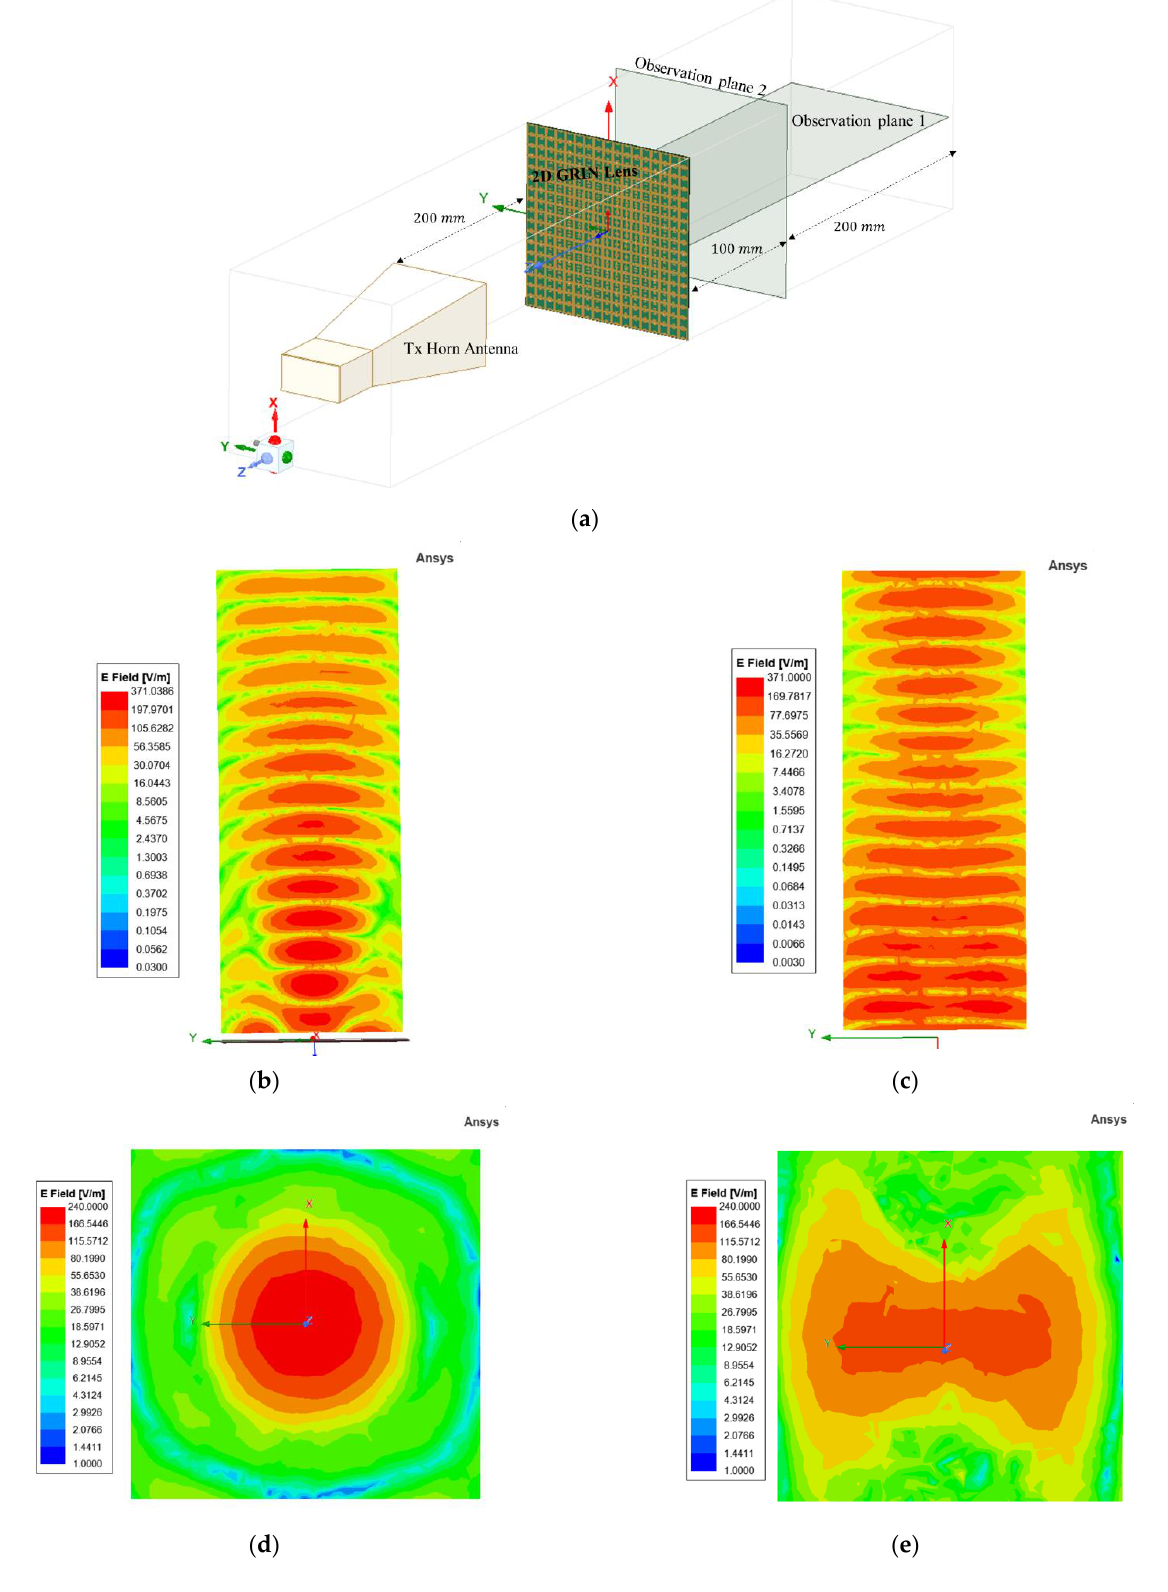
Figure 8. ( a ) Ansys HFSS setup for proposed 2D GRIN Metasurface Lens. ( b ) Azimuthal plane electric field distribution with lens and ( c ) without lens. ( d ) Vertical plane electric field distribution with lens and ( e ) without lens.